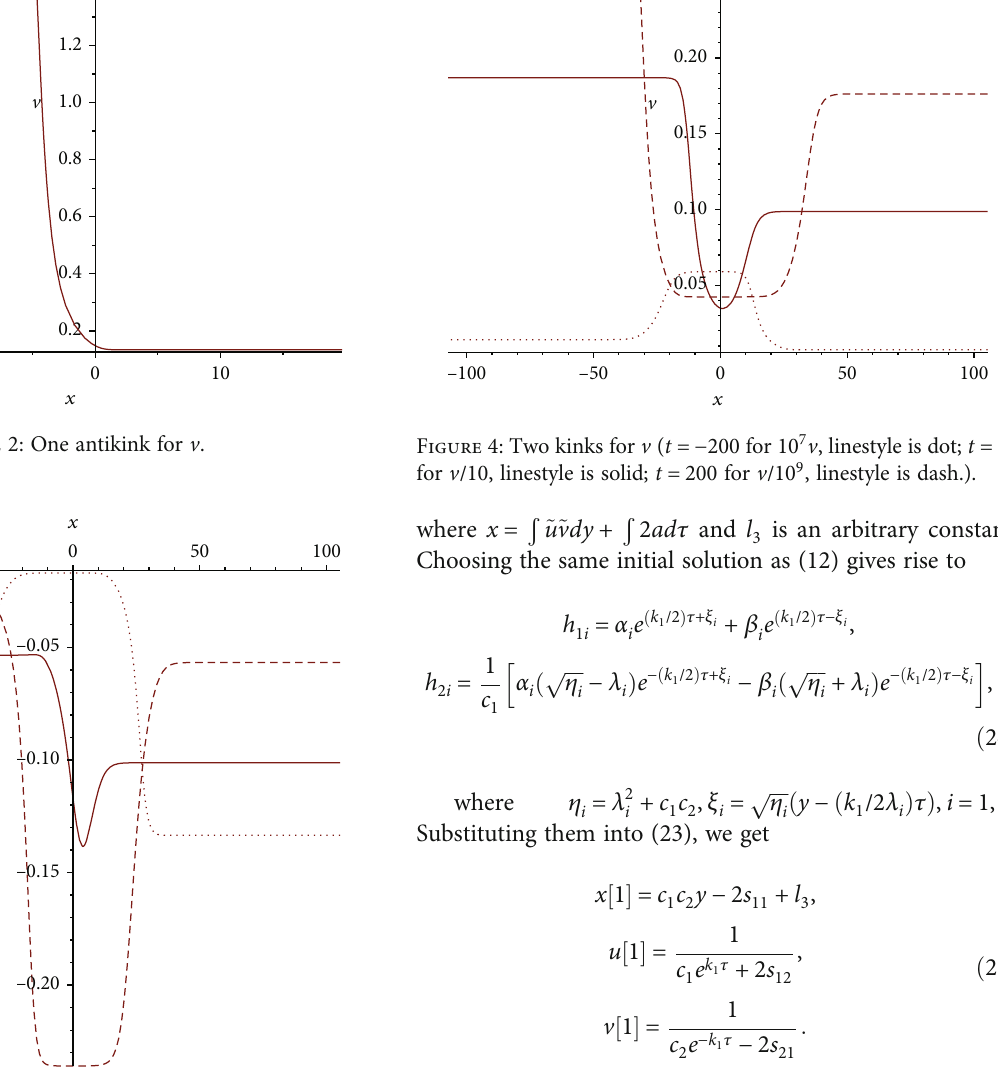
Figure 3: Two kinks for u ( t = − 200 for u /10 9 , linestyle is dot; t = 10 for u , linestyle is solid; t = 200 for 10 8 u , linestyle is dash).